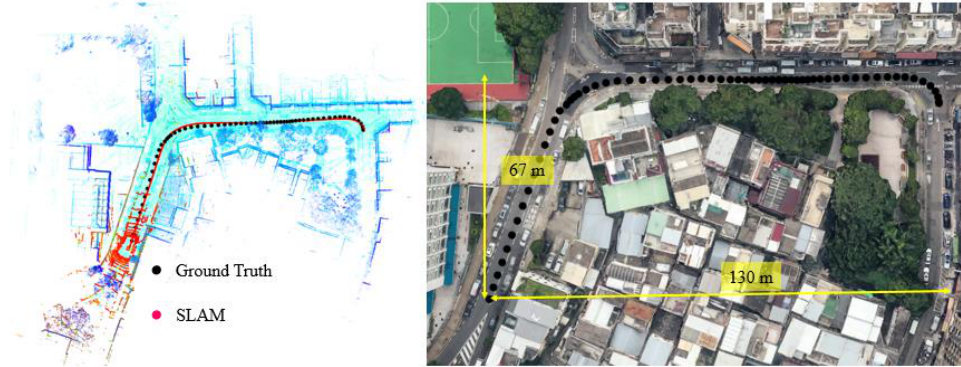
Figure A3. Experiment 6: the trajectory of NDT-based graph SLAM in a sub-urban area with dense traffic condition. The left panel indicates the generated points map and trajectory from SLAM. Top panel represents the snapshot in Google Maps. The black curve indicates the ground truth of the vehicle’s trajectory.